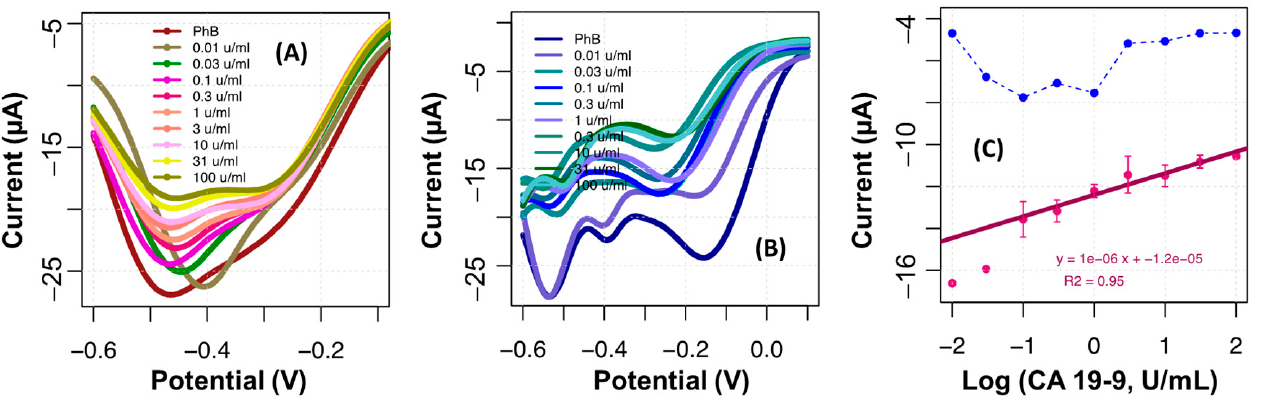
Figure 8. DPV voltammograms of MIP ( A ) and NIP ( B ) films assembled on Au-SPE and incubated consecutively with increasing concentrations of CA 19-9 standard solutions, from 0.10 to 100 U/mL, along with the corresponding average calibration plots ( C ), plotting MIP as dark-pink, and NIP as light-blue.